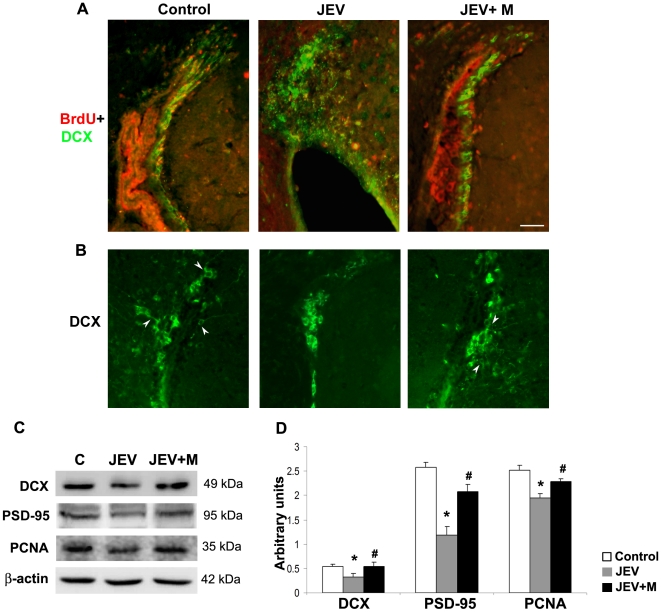
Population of migrating neuroblasts restored in adult infected SVZ by minocycline administration.Cryostat sections of brains from control, JEV and JEV+M animal groups were labelled for proliferating cells of neuronal lineage (BrdU+DCX double staining) (A) or for migrating neuroblasts (DCX positive cells) (B). Control SVZ show marked co-localization of BrdU (Alexa Fluor, red) and DCX (FITC, green). These double positive cells were distinctly lesser in the JEV-infected SVZ compared to control SVZ, which was however restored in JEV+M SVZ (A). DCX staining (FITC, green) show migrating neuroblasts in control SVZ and in SVZ from JEV+M animals with neurite extending outwards (shown by arrowheads), was completely absent in JEV-infected SVZ (B); scale bar is 50 µ. Protein isolated from SVZ of control, JEV and JEV+M animals were analyzed by immunoblot (C). Expression of DCX, PSD-95 and PCNA declined in JEV-infected SVZ, which in JEV+M SVZ was elevated almost to control levels. The graph represents densitometric quantification of proteins bands of DCX, PSD-95 and PCNA, normalised to β-actin (D). Values represent the means ± SEM from five animals in each group (* significant change from control p<0.05; # significant change from JEV samples p<0.05).